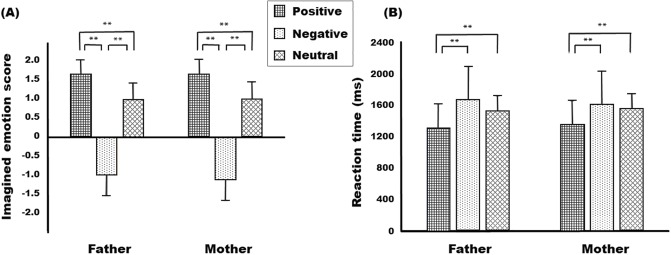
The imagined emotion scores (A) and reaction times (B) in each situation and each block condition.**p < 0.01.